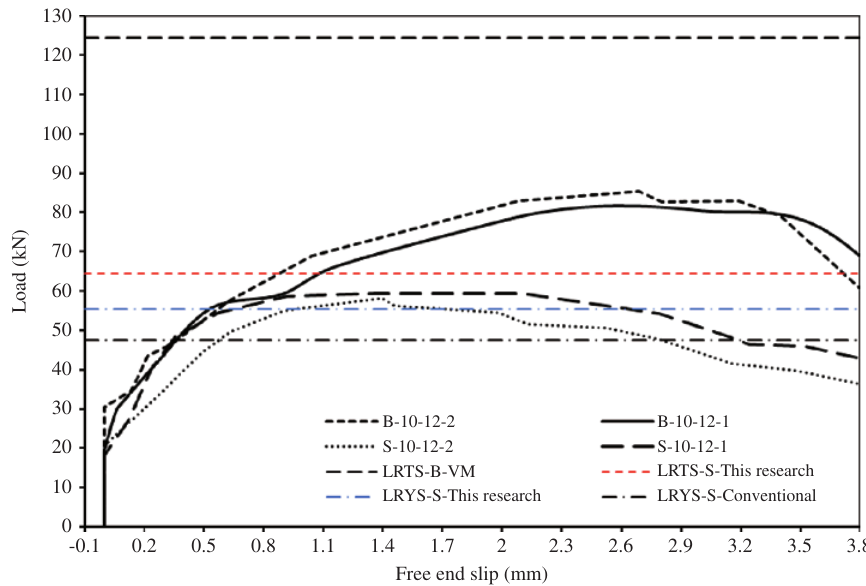
Figure 11: Load and free end slip relationship of 12 mm reinforcement bars and concrete (10 Φ embedment